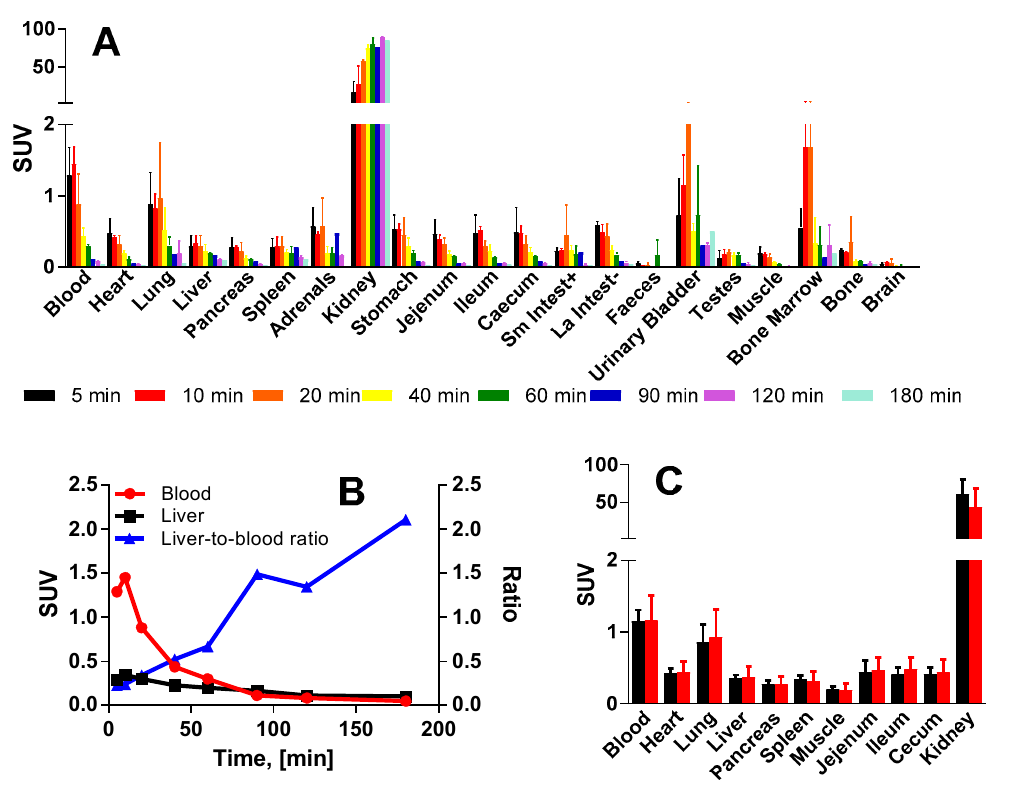
Figure 5. ( A ) Organ distribution of [ 68 Ga]Ga-C-803-GIP in male rats. Most tissues except kidney demonstrated rapid washout. ( B ) Radioactivity clearance from blood (red) and liver (black), and liver-to-blood ratio as a function of time (blue curve). ( C ) Organ distribution of [ 68 Ga]Ga-C803-GIP in rat showing lack of blocking effect when comparing the base-line study (only [ 68 Ga]Ga-C-803-GIP; n = 4; black bars) and the competition study ([ 68 Ga]Ga-C-803-GIP and excess of non-labeled precursor, C803-GIP; n = 4; red bars).